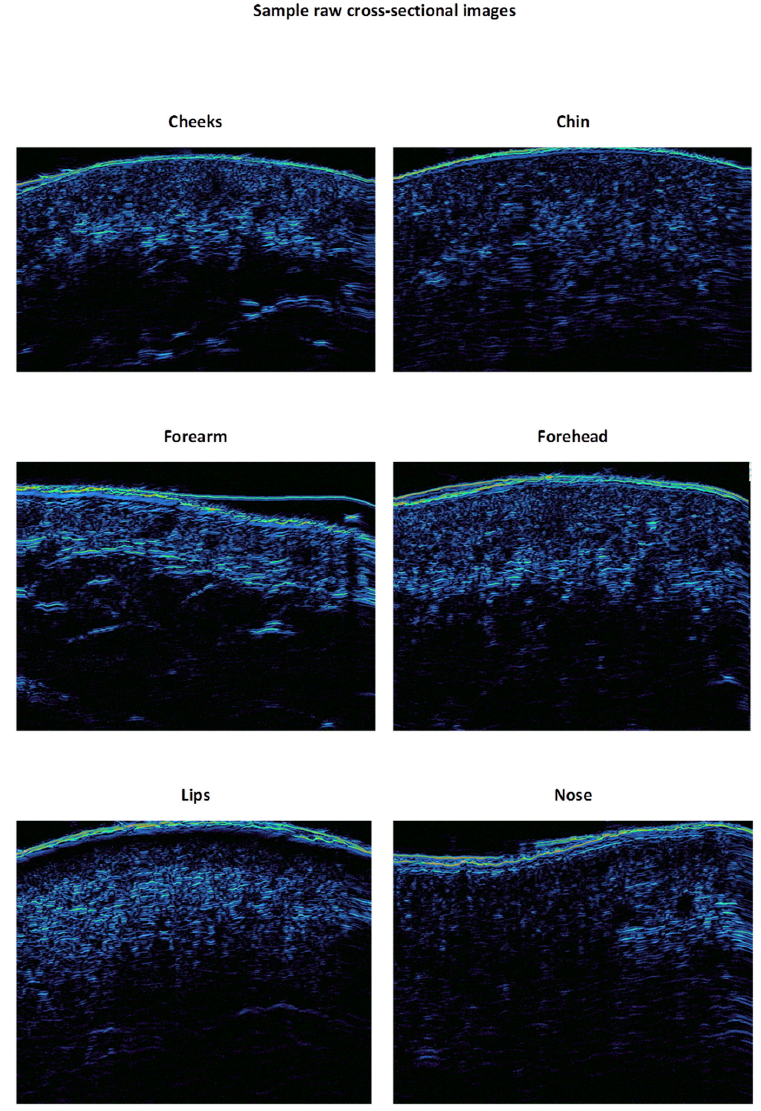
Figure 3. The typical high-resolution ultrasound images at the different skin sites: cheeks, chin, forearm, forehead, lips and nose. Table 3. The measured skin layer thickness of different volunteers at the different skin